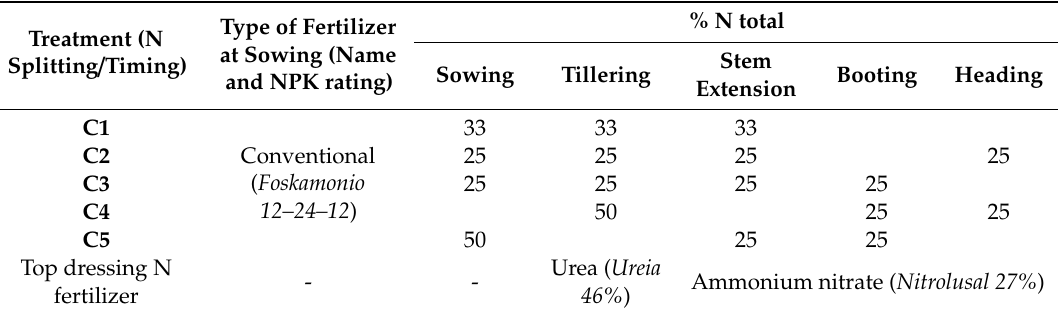
Table 5. Nitrogen fertilizer splitting (% of N total) and timing (phenological stage) treatments through the wheat cycle in Trial 2 (2016 / 2017), with Conventional N fertilizers. Crop stages dates between brackets.